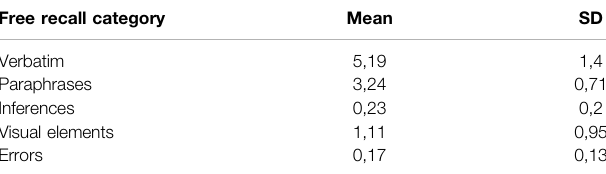
TABLE 3 | Means and standard deviations for each free recall category (N = 28).